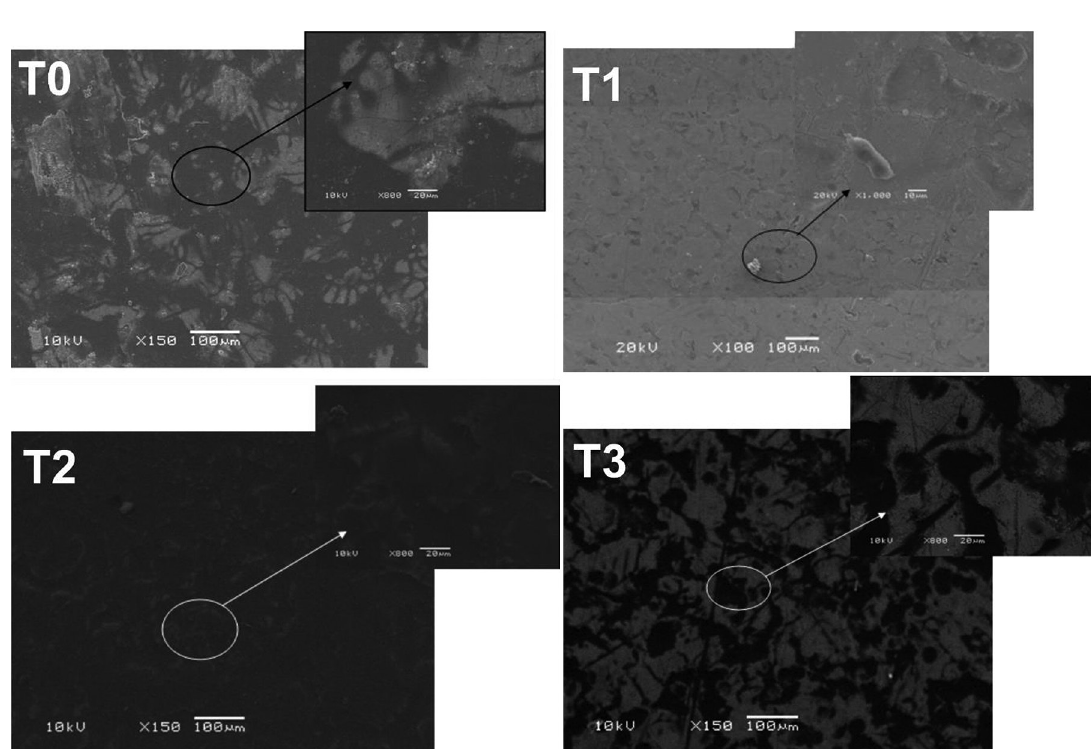
Figure 4. Micrographs obtained from SEM for siloxane-PMMA hybrid coatings with different TEOS ratios (T0, T1, T2 and T3), obtained on galvanized steel.